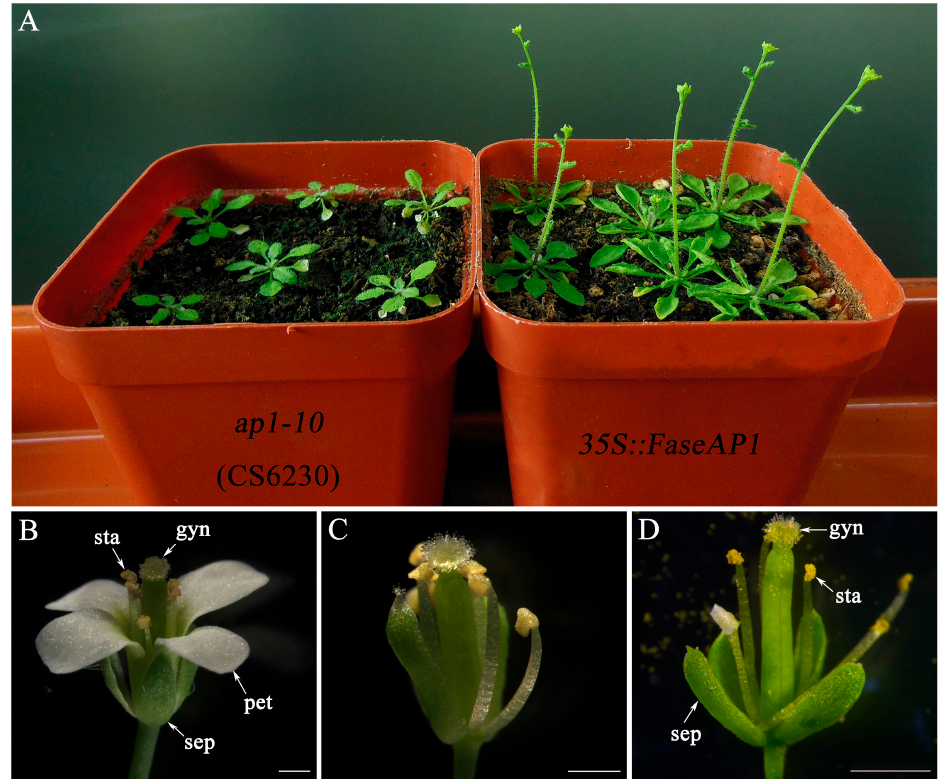
Figure 8. Phenotypes comparison of the wild-type, Arabidopsis ap1-10 mutant and 35S::FaesAP1 transgenic Arabidopsis ap1-10 mutant. ( A ) Arabidopsis ap1-10 mutant and 35S::FaesAP1 transgenic Arabidopsis ap1-10 mutant ( T-7 / ap1-10 ) cultured in the greenhouse under long-day condition (13 h light / 11 h dark) at 25 ◦ C light / 23 ◦ C dark for 23 days; ( B ) wild-type Arabidopsis flower with normal 4 whorls of floral organs; ( C ) Arabidopsis ap1-10 mutant flower with two carpelloid sepals in whorl 1 and the petal whorl missing. ( D ) T-15 independent line 35S:: FaesAP1 transgenic Arabidopsis ap1-10 mutant flowers with four normal sepals in whorl 1, six stamens in whorls 2 but one filament attached with a petaloid structure, and a normal gynoecium in whorl 3. Sepal (sep); petal (pet); stamen (sta); gynoecium (gyn). Scale Bars: ( B , C ) 500 µ m; ( D ) 1